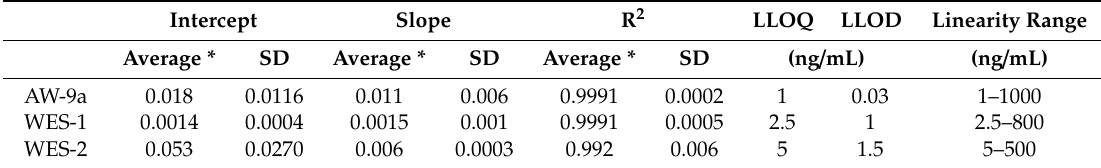
Table 1. Linearity results for AW-9a, WES-1, and WES-2 in human plasma. LLOQ, lower limit of quantitation; LLOD, lower limit of detection.